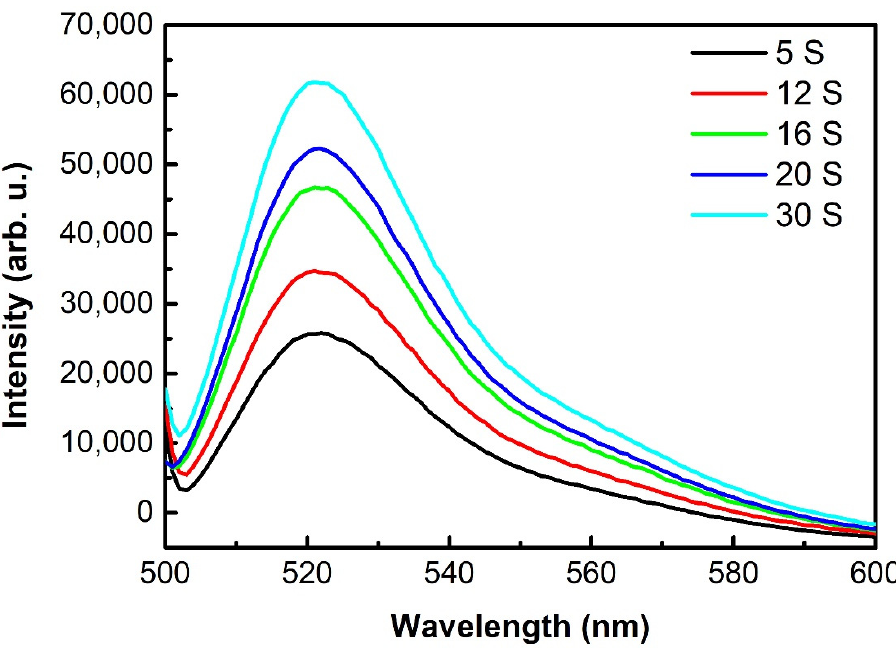
Figure 6. The fluorescence spectra of the 2,7-dichlorofluorescein (DCF) solutions obtained by changing the treatment time; 2,7-dichlorodihydrofluorescein diacetate (H2DCFDA) represents a non-fluorescent form of the dye. After the deacetylation in the NaOH solution, the non-fluorescent form (2,7-dichlorofluorescein, DCFH) was oxidized into the highly fluorescent form 2,7-dichlorofluorescein (DCF) by the RONS in the aqueous solution. The process of deacetylation was shown by hydrolysis with NaOH by mixing 0.5 mL of stock H2DCFDA solution with 2 mL of 0.1 M NaOH solution. The fluorescence was obtained at an excitation wavelength of 495 nm.